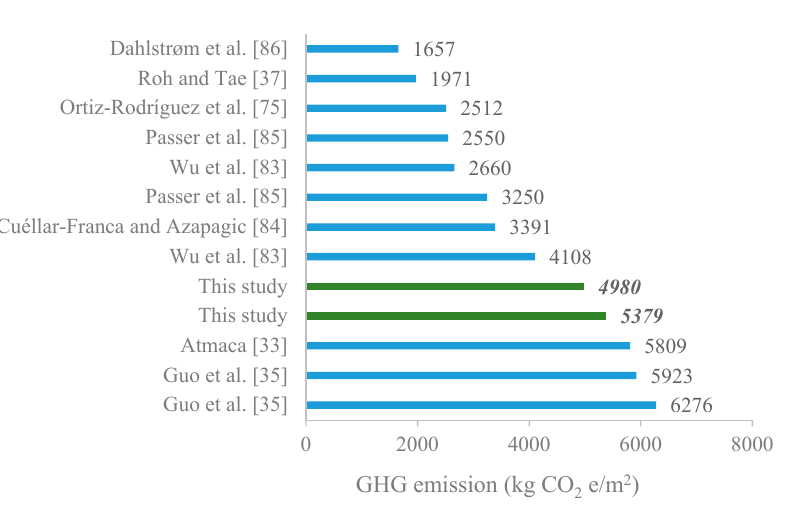
Figure 4 . Comparison of GHG emissions of residential buildings. Figure 4. Comparison of GHG emissions of residential